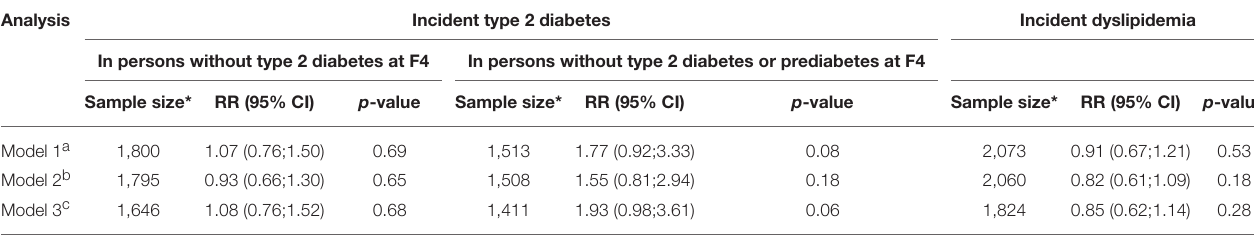
TABLE 5 | Association of H. pylori seropositivity with incident type 2 diabetes and dyslipidemia.